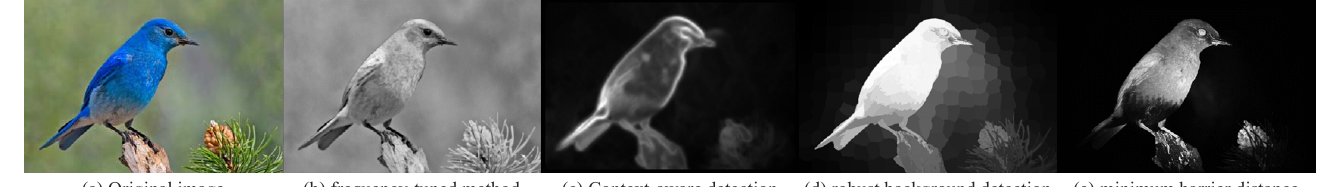
Figure 2. Results of candidate saliency estimations.